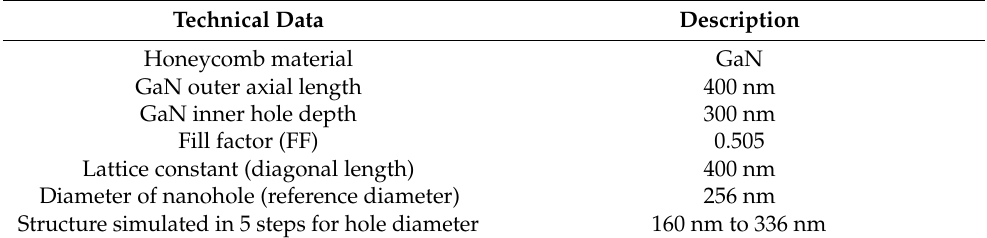
Table 3. Design parameters of the honeycomb structure incorporated into the steam generator.